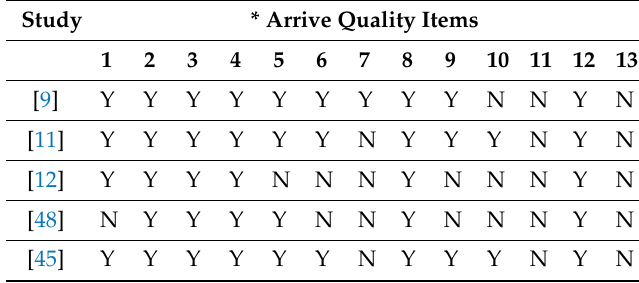
Table 3. Methodological quality assessment of animal studies using ARRIVE quality assessment criteria. Study